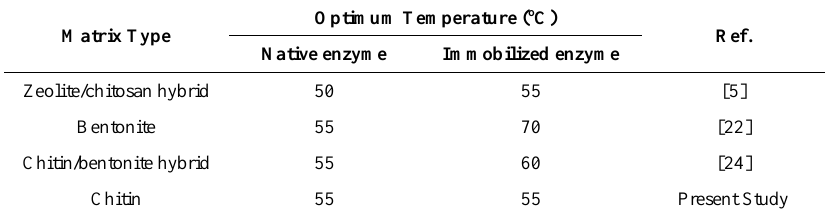
Table 1. Optimum temperature of the A. fumigatus α-amylase in the latest experiments